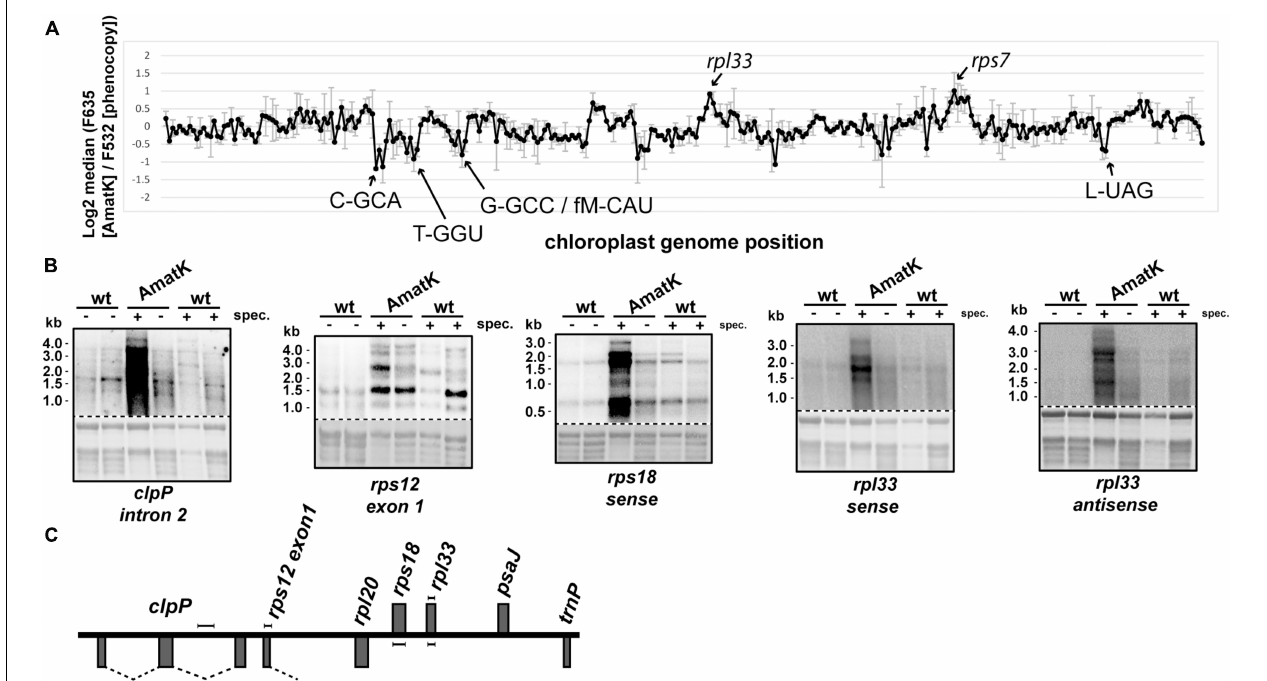
FIGURE 6 | Expression analysis of the AmatK chloroplast genome. (A) Microarray survey experiment of chloroplast RNAs. Two µ g of total leaf RNA from 10 day old AmatK plants and wt plants treated with low doses of spectinomycin (phenocopy control) were labeled with Cy5 (F635) and Cy3 (F532), respectively, and hybridized to a tobacco whole plastid genome tiling microarray. Each PCR probe was present in 12 replicates on the array and two biological replicates were performed. The average and standard deviation of the log2 signal ratios F635/F532 across the biological replicates was calculated and plotted agains the genomic position on the tobacco plastid genome (accession Z00044.2). Increase or decrease of RNA from AmatK plants relative to phenocopy controls was not significant (FDR > 0.05), rarely reaching a log2 fold-change of 2. We nevertheless labeled peak areas of enrichment. (B) RNA gel blot analysis of the rpl33 - clpP genomic region. 5 µ g of total plant RNA from AmatK and wt plants was separated on a 1.2% denaturing agarose gel and probed with strand specific RNA probes as indicated below each autoradiograph. Some plant samples were treated with spectinomycin (spec.). Loading and RNA integrity were controlled by staining rRNAs with methylene blue (below autoradiographs; The autoradiographs and the corresponding methylene blue stains are separated by a dashed line). (C) Schematic representation of the clpP-rpl33 genomic region. Genes on top of the line are transcribed from right to left, genes below the line from left to right. Probes used for the RNA gel blot experiments shown in (B) are indicated by handle bars. Introns are indicated by dashed lines. Note that the intron in rps12 is trans-spliced, i.e., only the first part of the intron is located within this genomic locus.